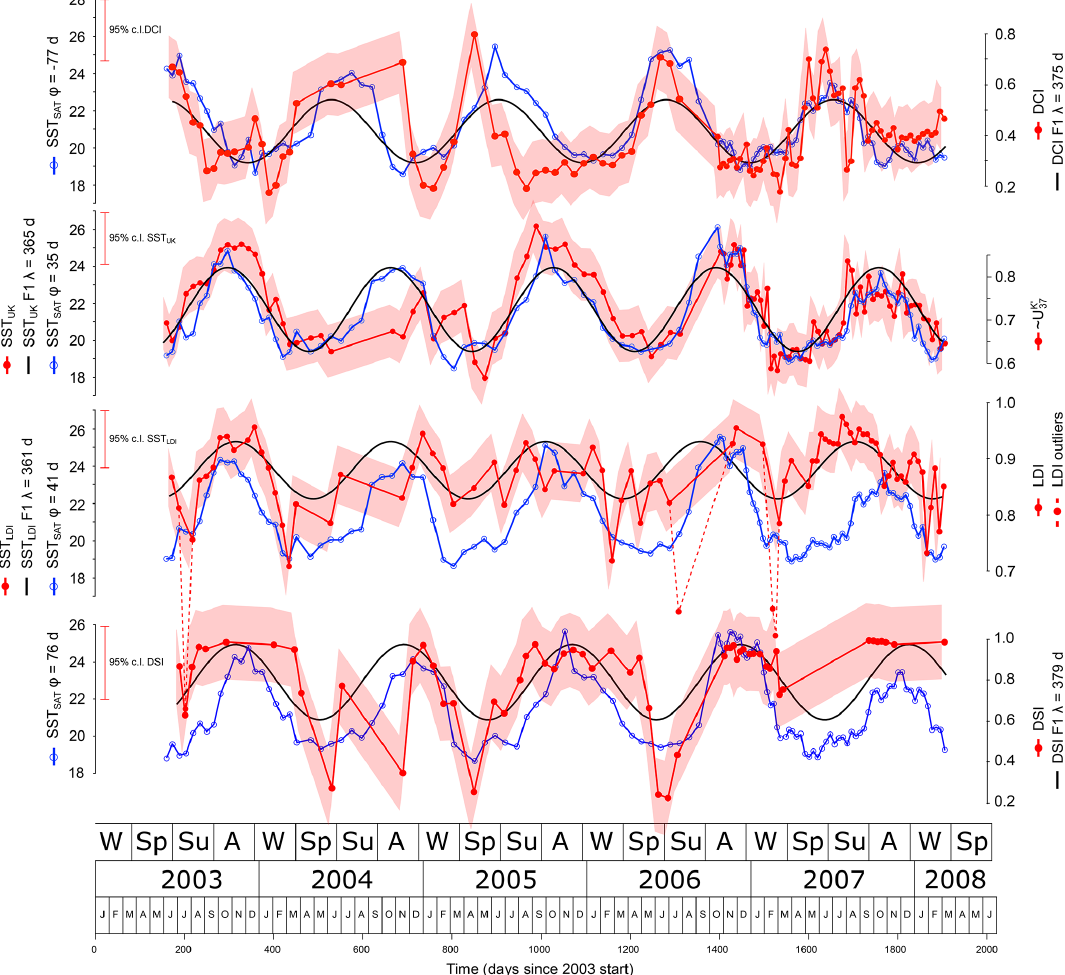
Figure 6. Proxy-derived SST (red, filled circles), their annual frequency component (F1, black), and satellite-derived SST SAT (blue, empty circles). The phase shifts of the SST SAT are such that correlation with the proxy-derived SST is highest. Corresponding proxy values are indicated on the right side of the panels. Shaded red areas show the 95% confidence